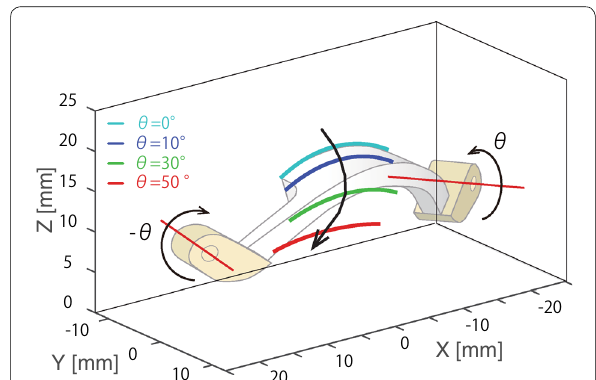
Fig. 5 ELGM deformation; each line shows the part in contact with the eyelid shown in Fig. 3. These are related to rotational displacements of 0, 10, 30 and 50°. The black line shows the locus of the black dot in Fig. 3